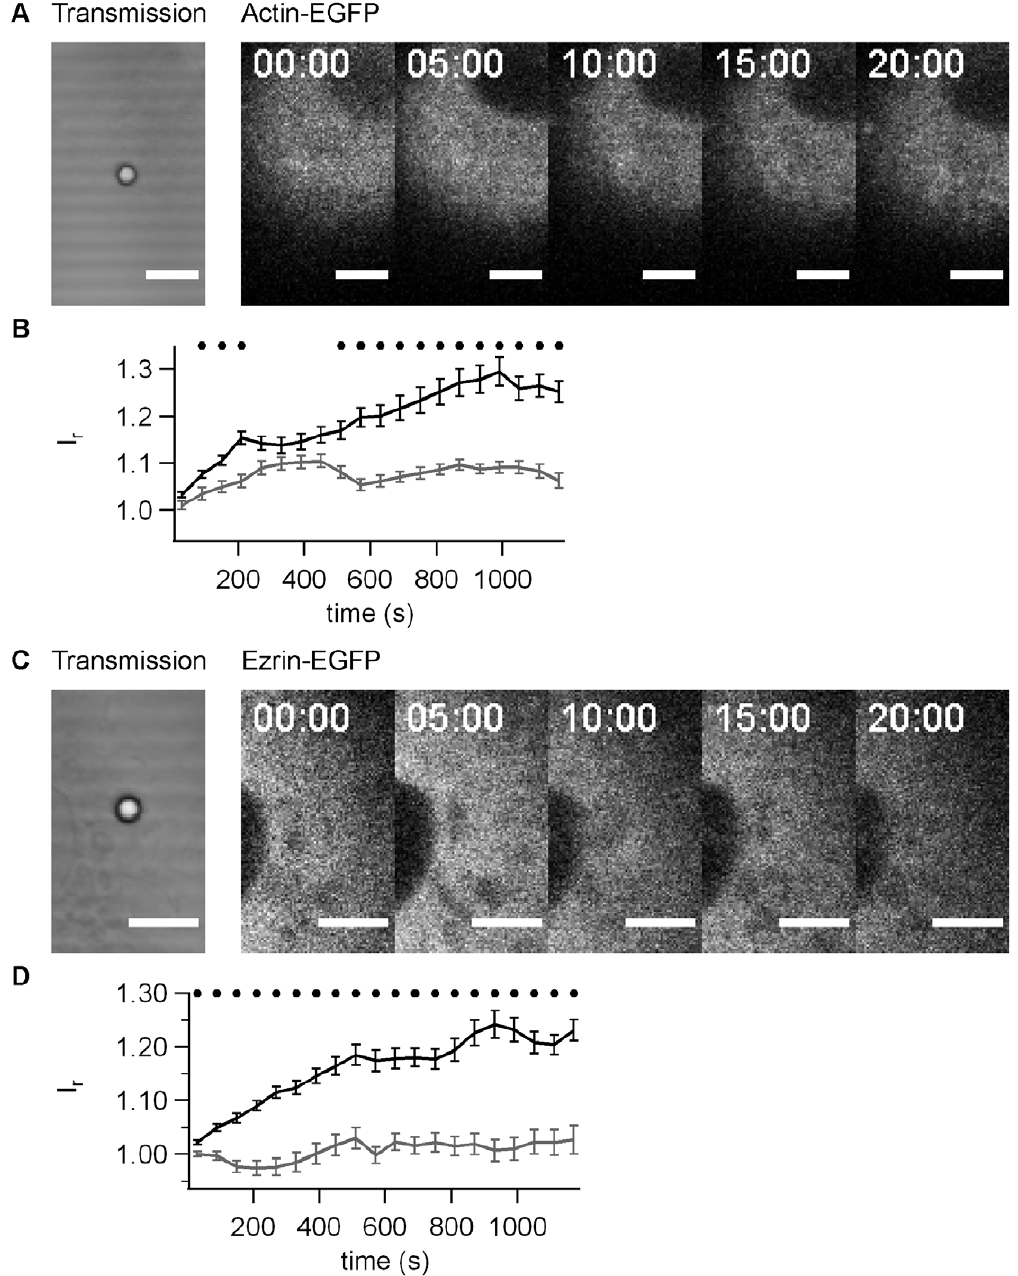
Figure 4. Accumulation of actin-EGFP and ezrin-EGFP depends on force. A) Typical time lapse for actin-EGFP for beads without force application by laser tweezers. B) Relative fluorescence intensity I r as a function of time for actin-EGFP averaged over 20 beads. C) Typical time lapse for ezrin-EGFP for beads without force application by laser tweezers. D) Relative fluorescence intensity I r as a function of time for ezrin-EGFP averaged over 30 beads. Black line: application of F # 100 pN, grey line: F=0. Black dots mark statistical significant different values with force and without force (t-Test significance level p , 0.01).